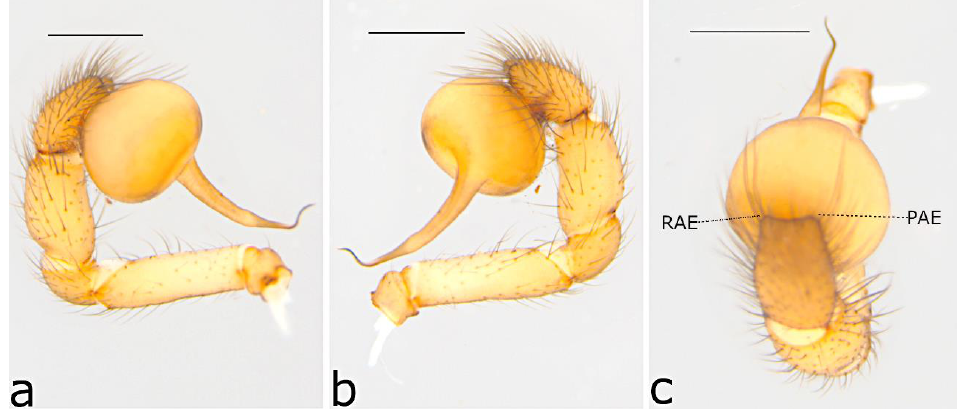
Figure 74. Ariadna woinarskii sp. nov. ♂ holotype (SAMA NN31200) from Kangaroo Island (SA): ( a ) left pedipalp, prolateral view; ( b ) same, retrolateral view; ( c ) same, cymbium. Scale bar = 0.5 mm.